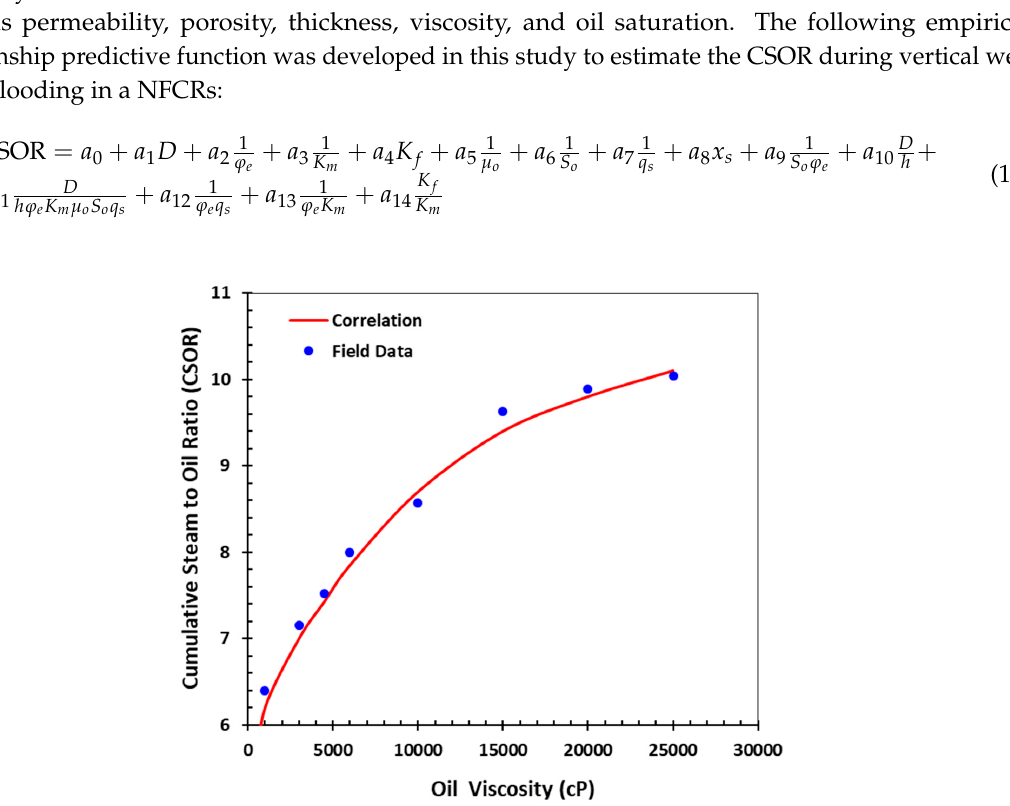
Figure 2. CSOR vs. oil viscosity for the database Figure 1. CSOR vs. oil viscosity for the database analyzed.